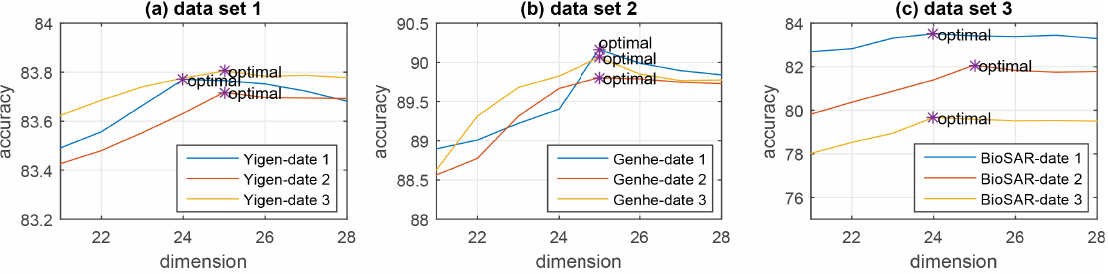
Figure 5. ( a – c ) are respectively thetests of the optimal feature dimension on three dates of each data set. Here, “optimal” means that the chosen dimensions of the feature can fully represent the whole feature generated by sparse manifold expression without the sparse feature being